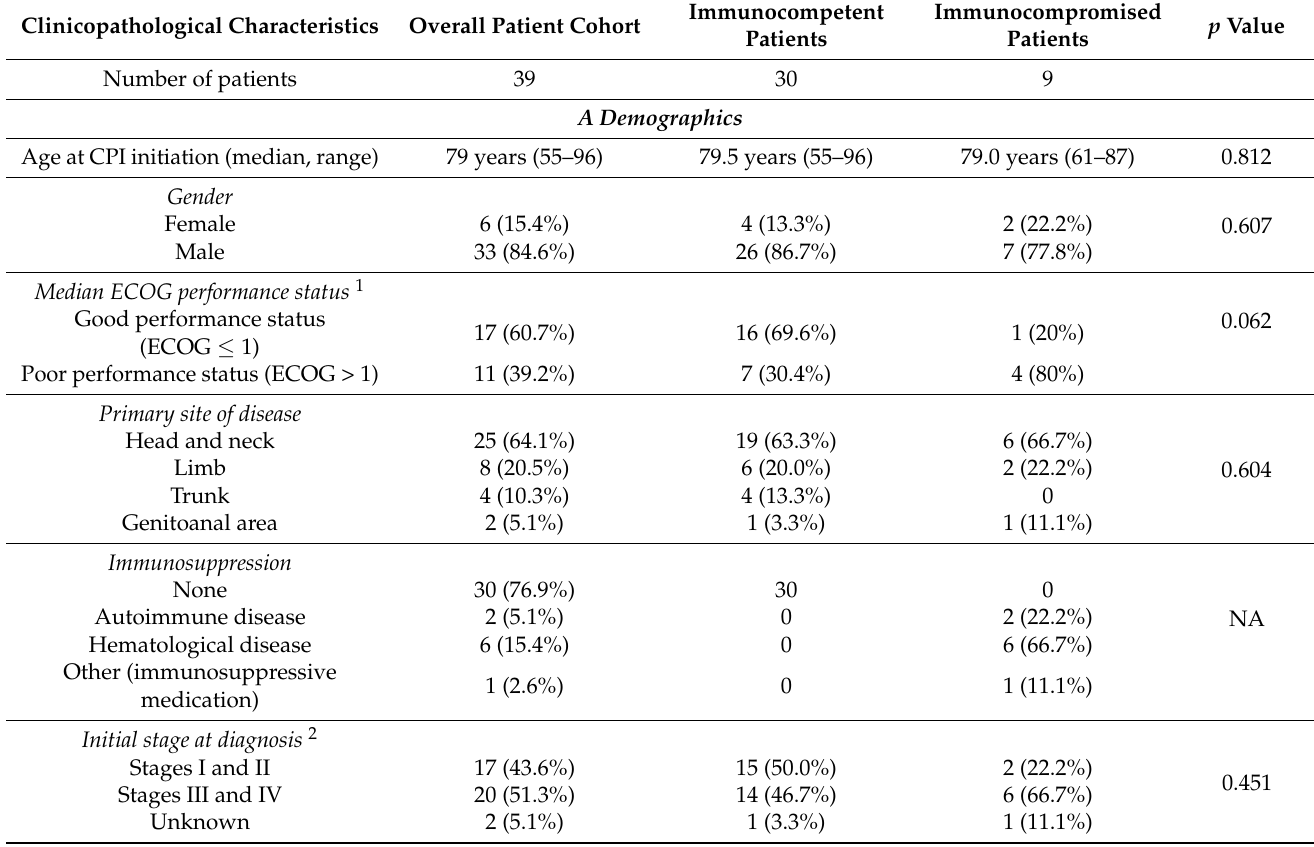
Table 1. Baseline patient characteristics and treatment